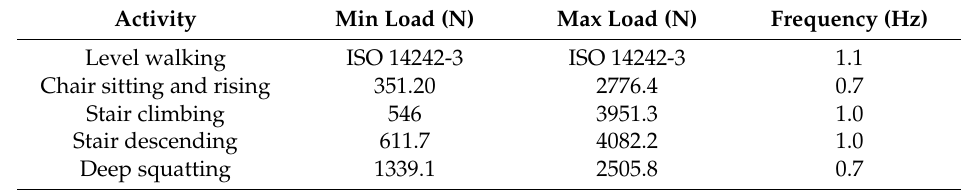
Table 1. Axial load ranges for each motor task and the rotation frequency imposed during simulation.